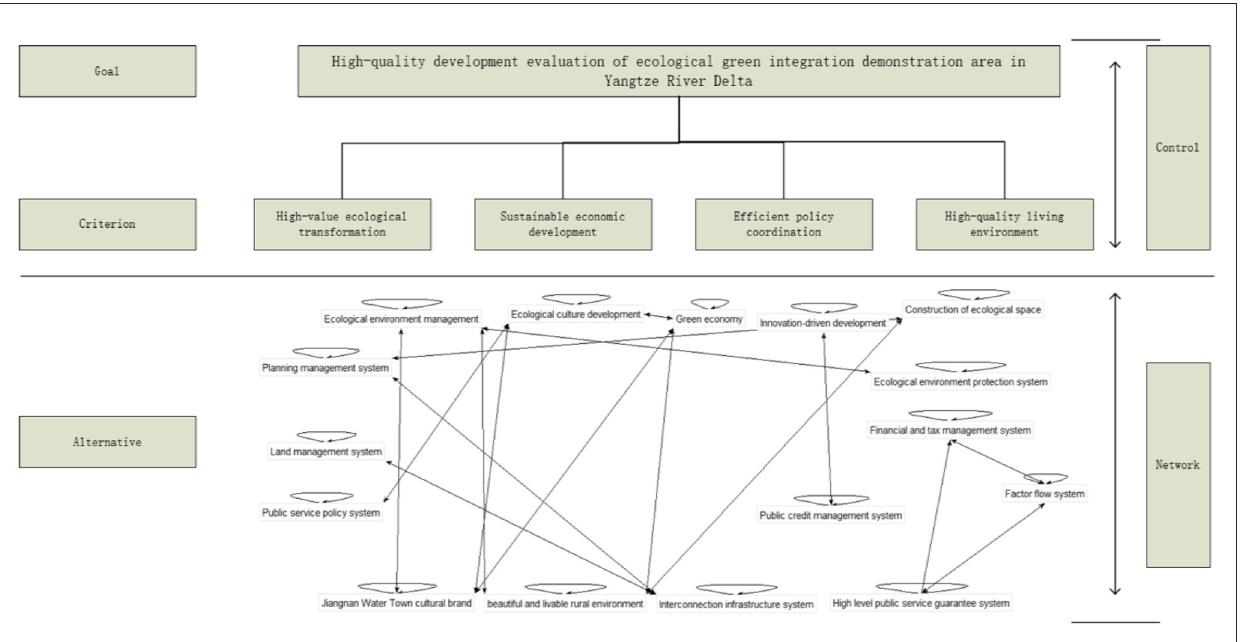
FIGURE2 High-quality development evaluation model of Yangtze River Delta eco green integrated development demonstration